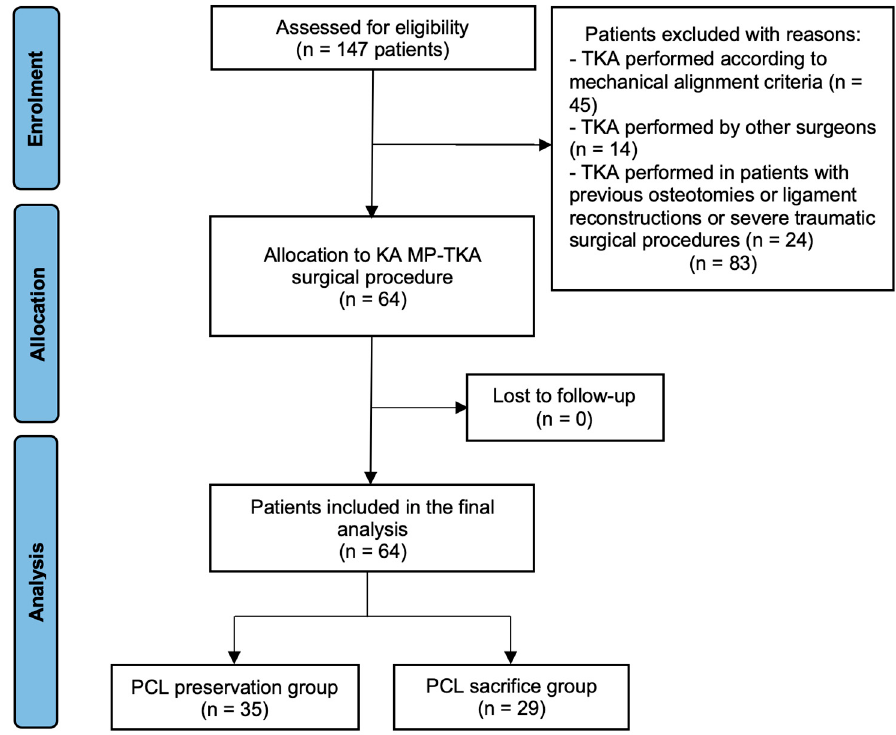
Figure 2. Flow diagram of study: all patients. TKA: total knee arthroplasty; KA MP-TKA: kinematic alignment medial pivot- total knee arthroplasty; PCL: posterior cruciate ligament.